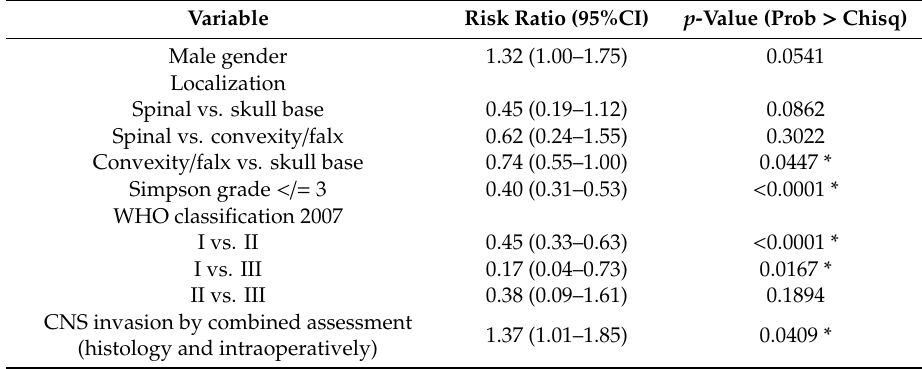
Table 3. Multivariate analysis of the combined histopathological and intraoperative assessment of CNS invasion (Cox proportional